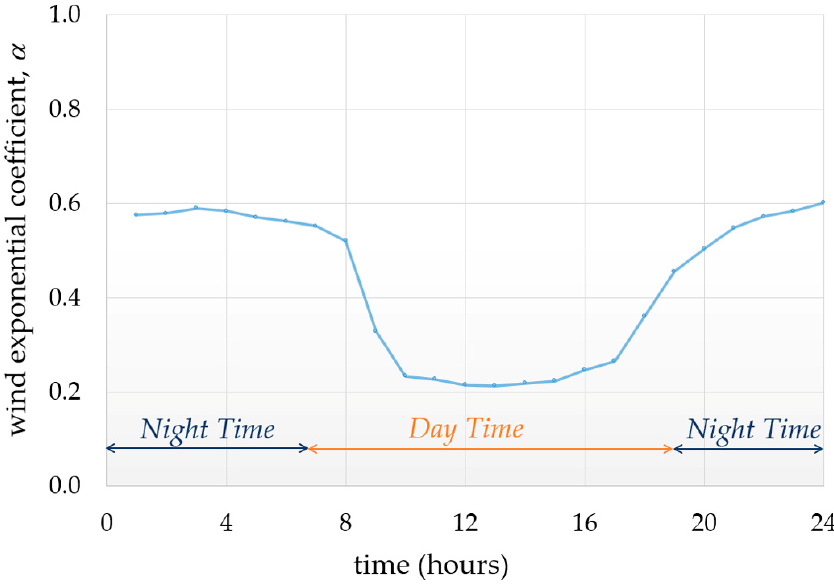
Figure 1. The 24-h wind profile information used for the study.